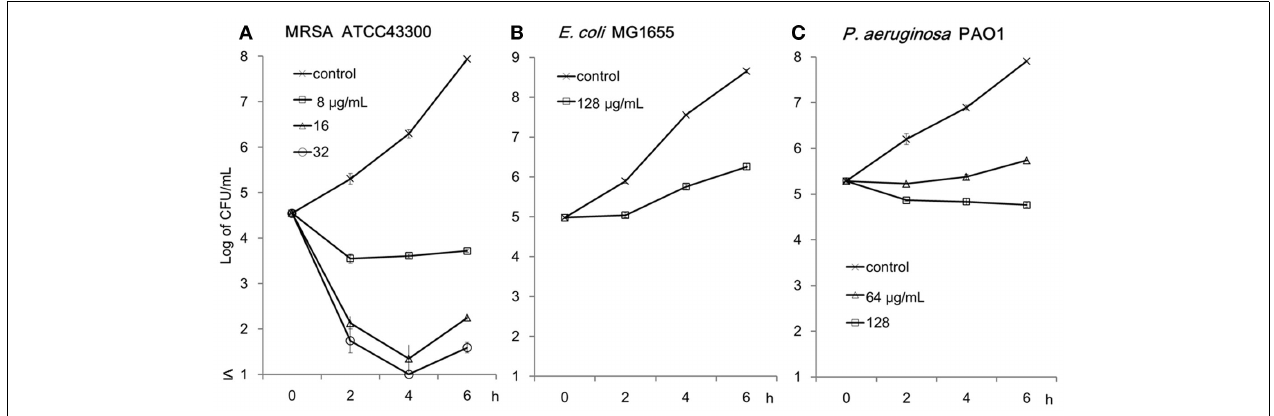
FIGURE 3 | Killing activity of C16 against MRSAATCC43300 (A), E. coli MG1655 (B), and P. aeruginosa PAO1 (C). Cells were incubated with C16 in Muller–Hinton broth at 37˚C on a shaker. Residual cells after 2, 4, and 6h